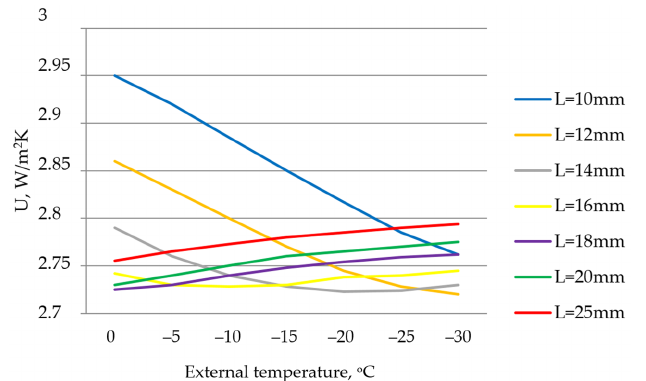
Figure 3. Dependence of the gap width and the outdoor temperature on the U − value of a double- pane window ( ε = 0.84) (summarized data from cited papers).